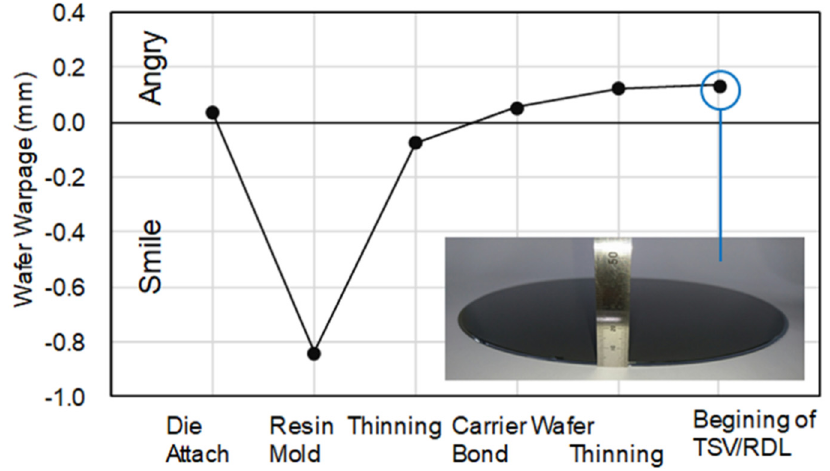
Figure 18. Details of wafer warpage in each step of COW process.